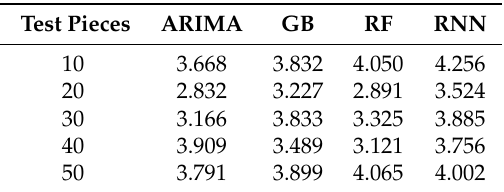
Table 1. Mean MSE values for each method for each different number of test pieces (multiplied by 10 − 3 ). GB, Gradient Boosting.